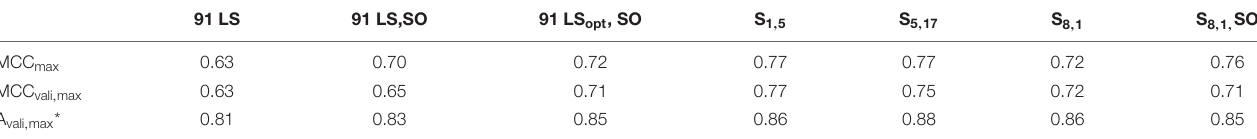
*Accuracy is shown for the model with best validation MCC. Best models’ performance data are written in bold. LS, Literature scales; SO, Strategy optimization; LS opt , Scales optimized with scale table optimization workflow; S x , y , Generated scale table with x scales, optimization procedure y of 20. Best test set Matthew’s